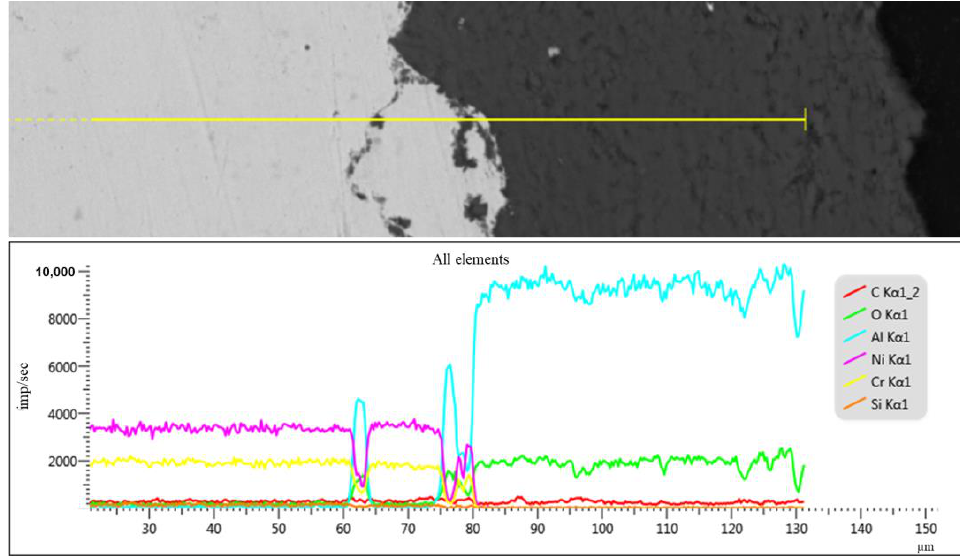
Figure 7. Distribution of elements along the cross-sectional line of the three-layer gradient coating.